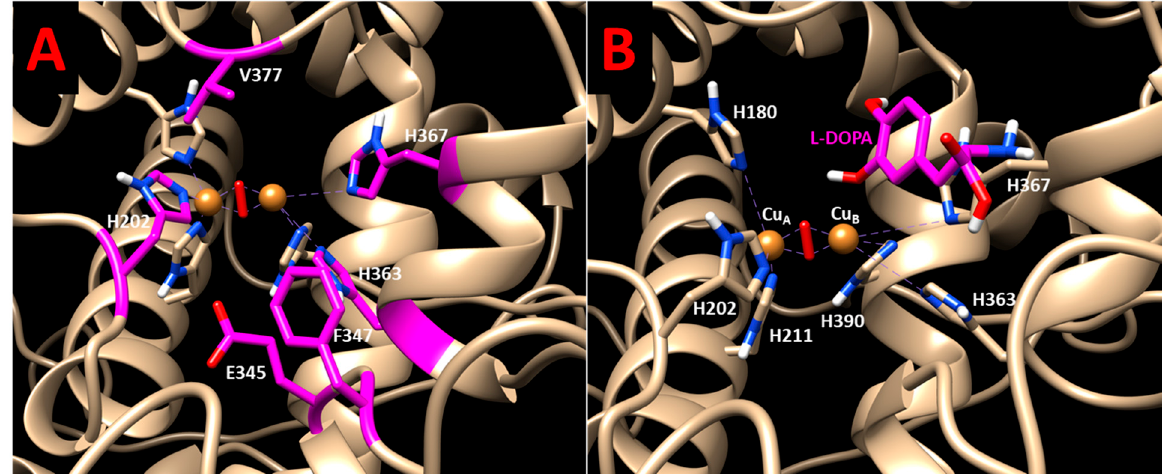
Figure 6. Molecular docking of L-DOPA and Tyr: ( A ) The residues of WT involved in substrate docking at all temperatures are shown in the active site. These residues include H202, E345, F347, H363, H367, and V377; ( B ) the L-DOPA molecule (magenta) is docked in the active site of WT. The computational docking shown here measures the binding energy of L-DOPA in the enzyme-substrate complex [Tyr*L-DOPA]. The two copper atoms at the active site of Tyr are shown by bronze spheres. They are coordinated by H180, H202, H211, H363, H367, and H390.